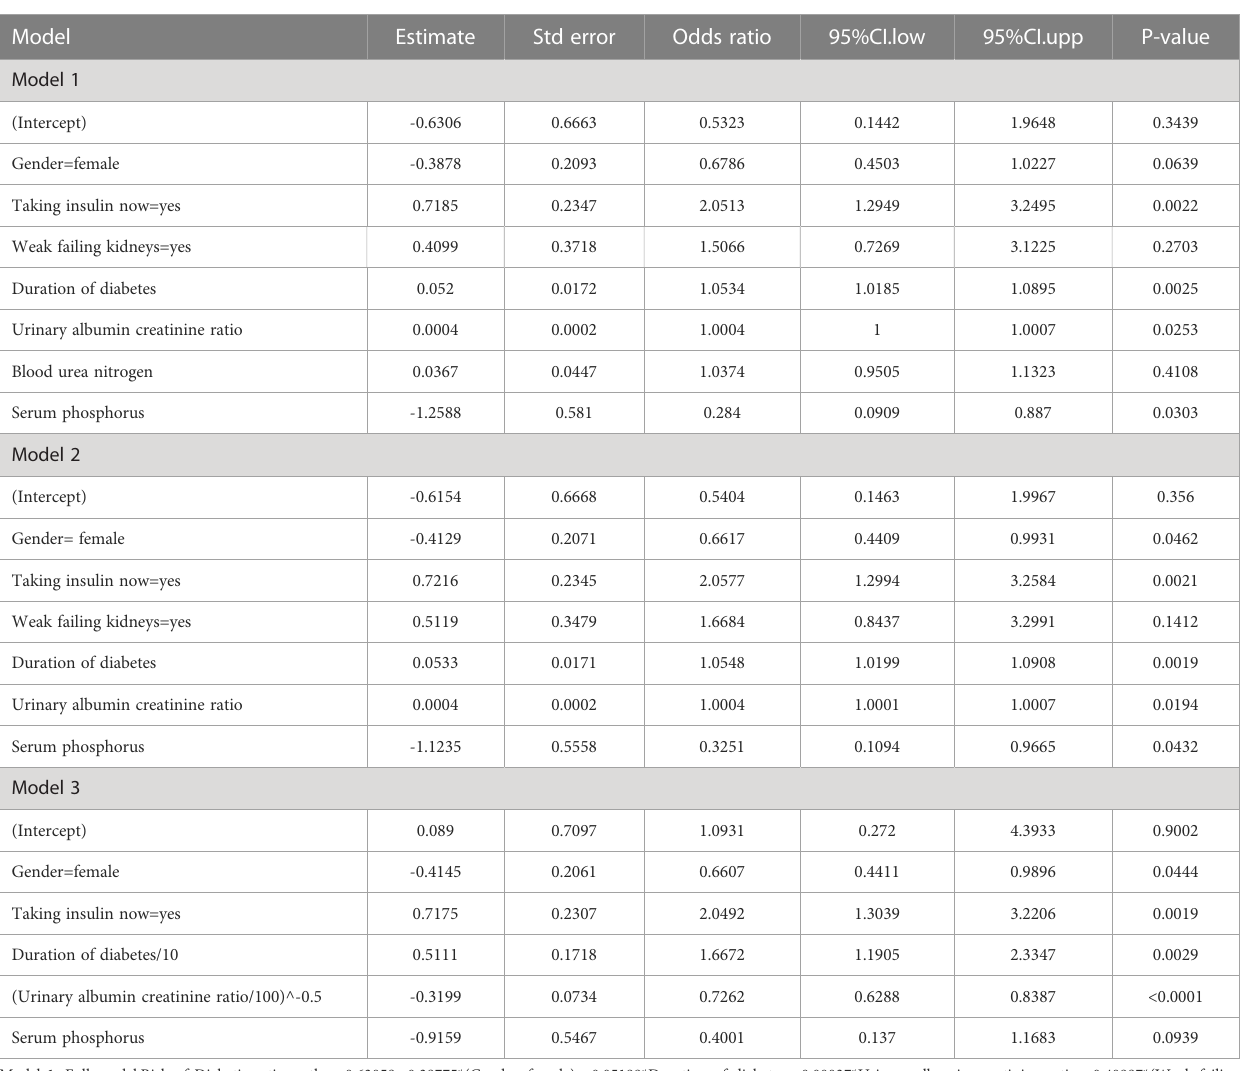
TABLE 2 Logistic regression analysis for risk factors in three